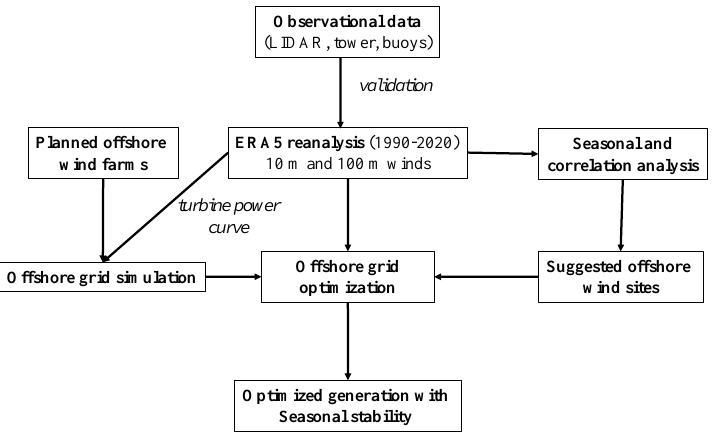
Figure 1. Flowchart of analysis, including data sources, validation, methods of analysis, power grid simulation, and